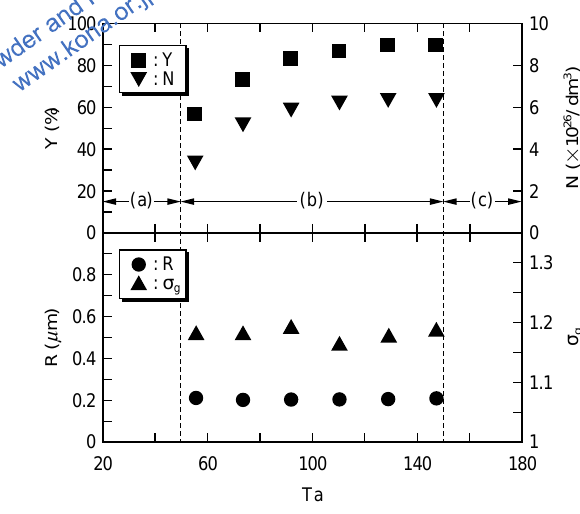
Fig. 6 Dependence of particle size, σ g , yield and particle num- ber density on Ta number. (a) Polydispersed region, (b) monodispersed region, (c) agglomerate region.